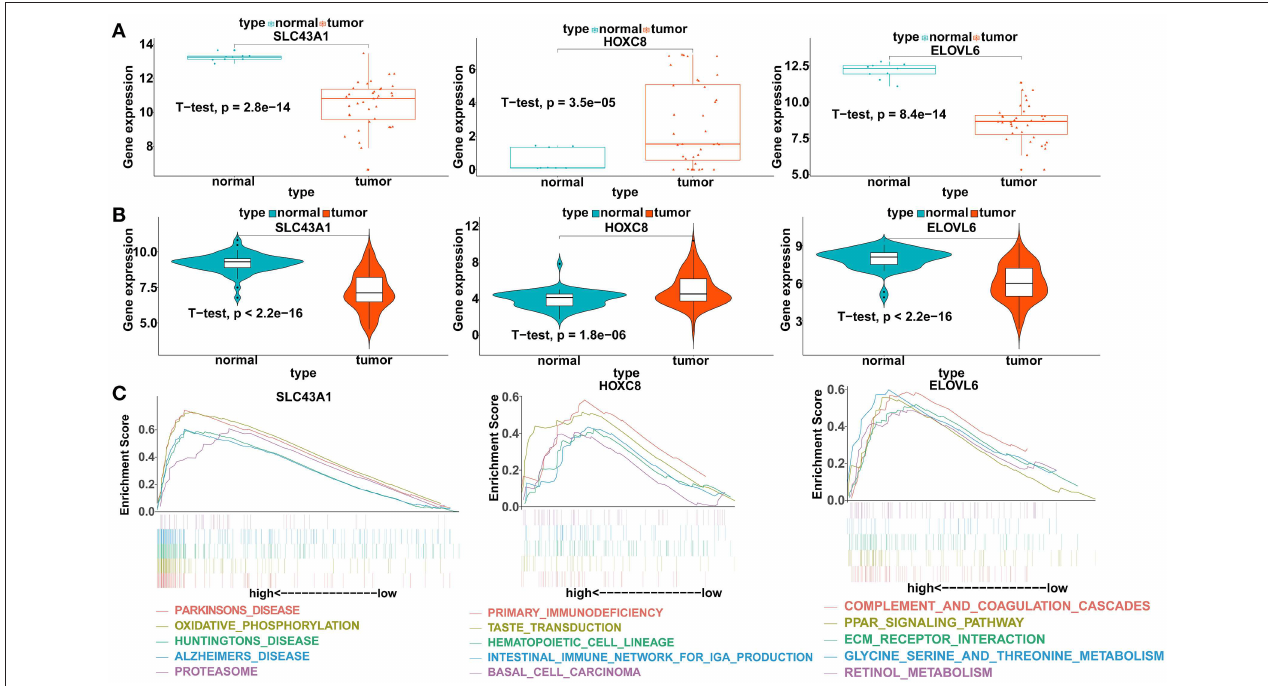
FIGURE 6 | Validation of the expression levels and gene set enrichment analysis (GSEA) of SLC43A1, HOXC8, and ELOVL6. (A) Scatter plots of mRNA levels of SLC43A1, HOXC8, and ELOVL6 in the TCGA training dataset. (B) Violin plots of mRNA levels of SLC43A1, HOXC8, and ELOVL6 in the GSE26566 validation dataset. (C) The top five functional gene sets enriched in the CCA samples are listed, which showed high expression of SLC43A1, HOXC8, and ELOVL6.